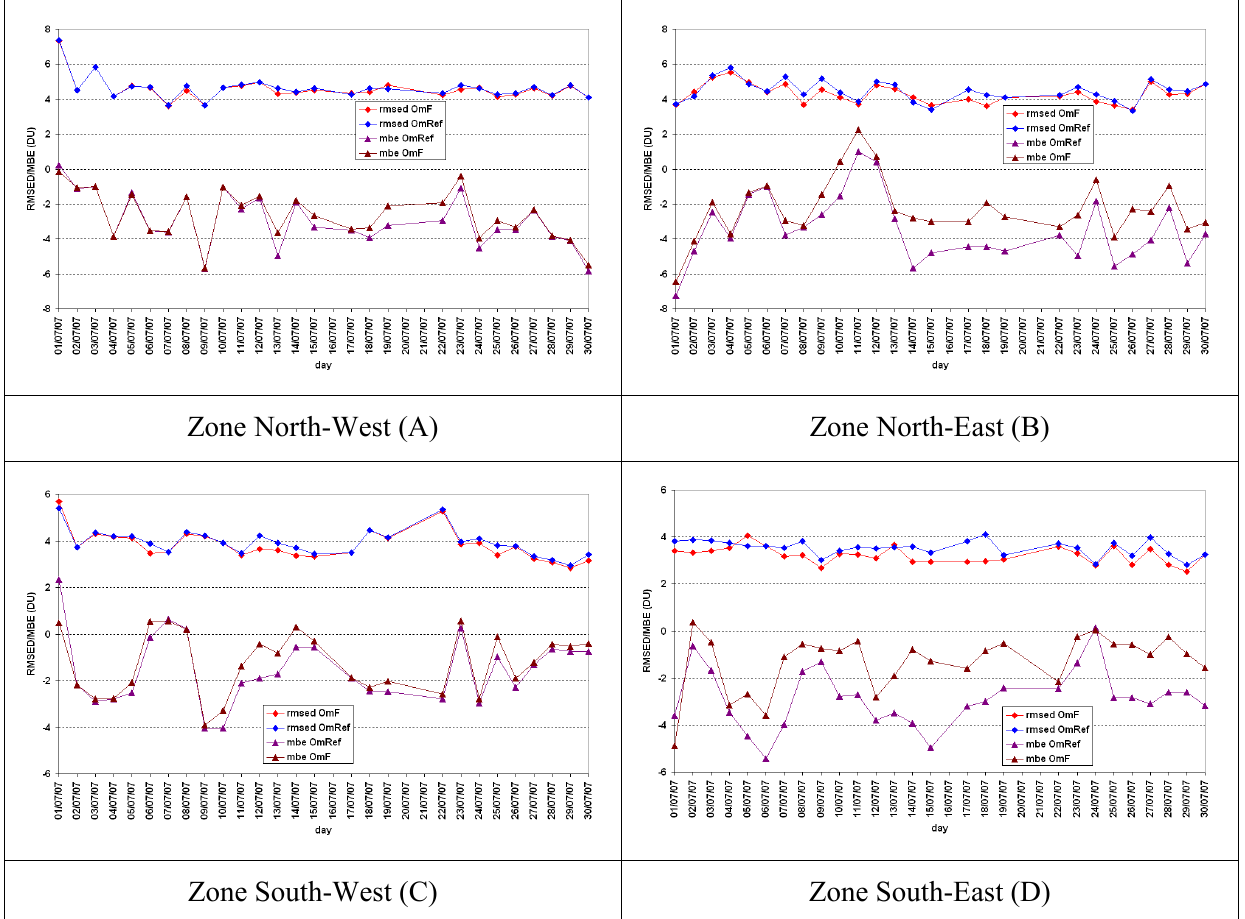
Fig. 7. Temporal evolution of the general statistics RMSED and MBE calculated for the differences (observations minus model/assimilation forecasts) for the four quadrants of the domain (defined in Fig. 2). The statistics were calculated for two types of differences called OmF (i.e. innovations) and OmRef (corresponding to the model reference run). The symbols are as follows: diamonds for the debiased RMSE “forecast” or “reference” (red or blue respectively); and triangles for the MBE “forecast” or “reference” (brown or violet respectively). The unit measure is DU.